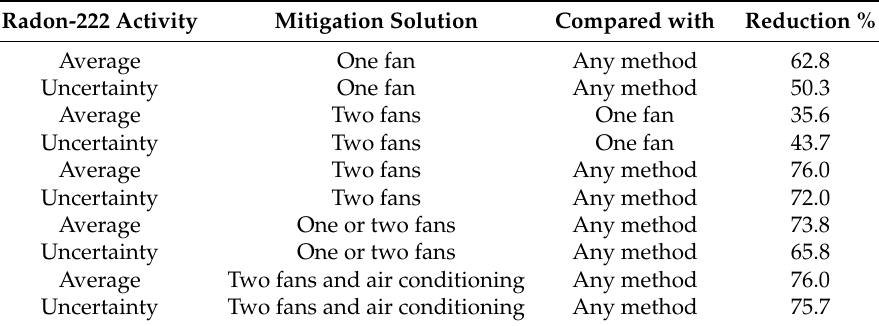
Table 5. Concentration reduction after mitigation systems